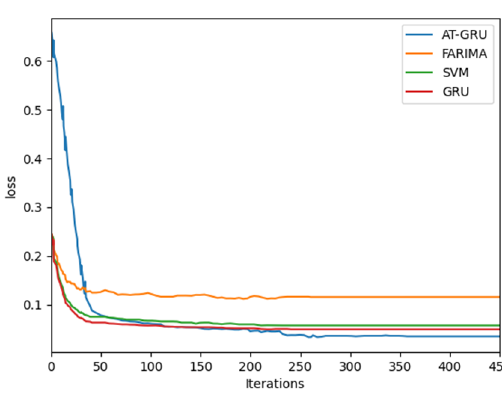
Figure 11. Model fitting effect.